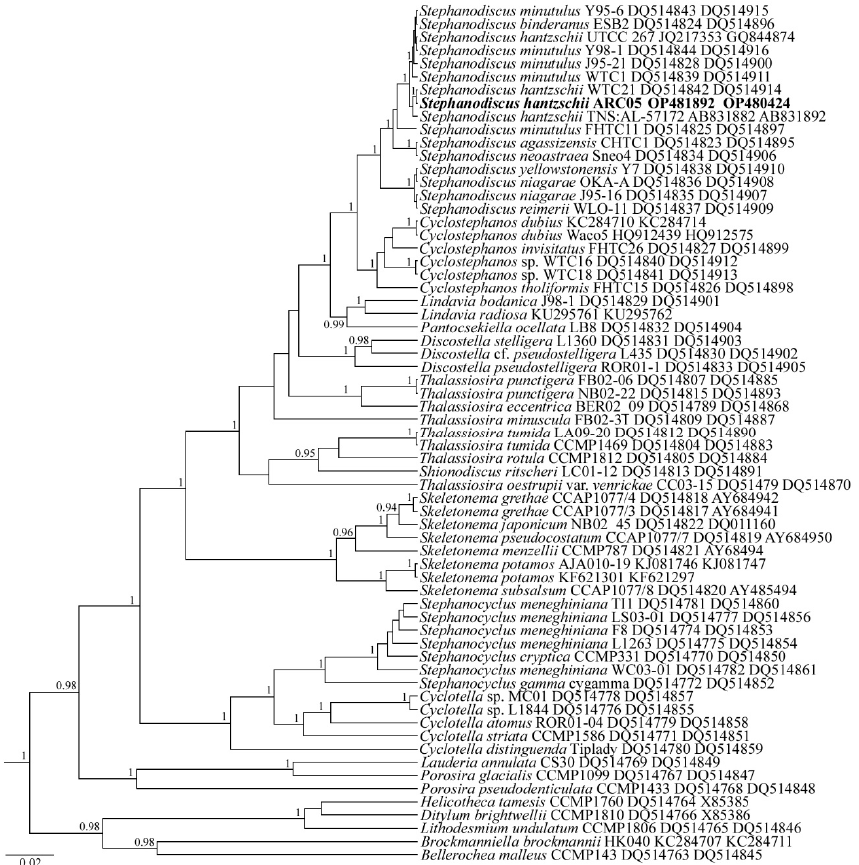
Figure 7. Phylogenetic position of the strain Stepanodiscus hantzschii ARC05 (indicated in bold) based on Bayesian inference for the partial 18S rRNA and rbc L genes. Total length of the alignment is 1408 characters. Posterior probabilities exceeding 0.9 of BI (constructed by Beast) are presented in order on the nodes. Strain numbers (if available) and GenBank numbers are indicated for all se ‐ quences.